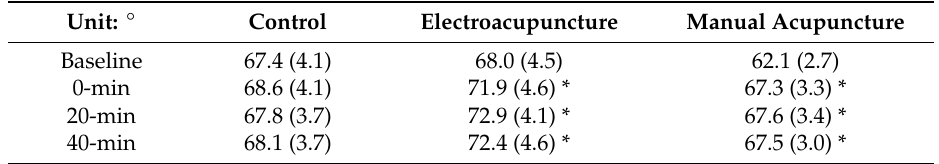
Table 3. Changes on hip flexion ROM.